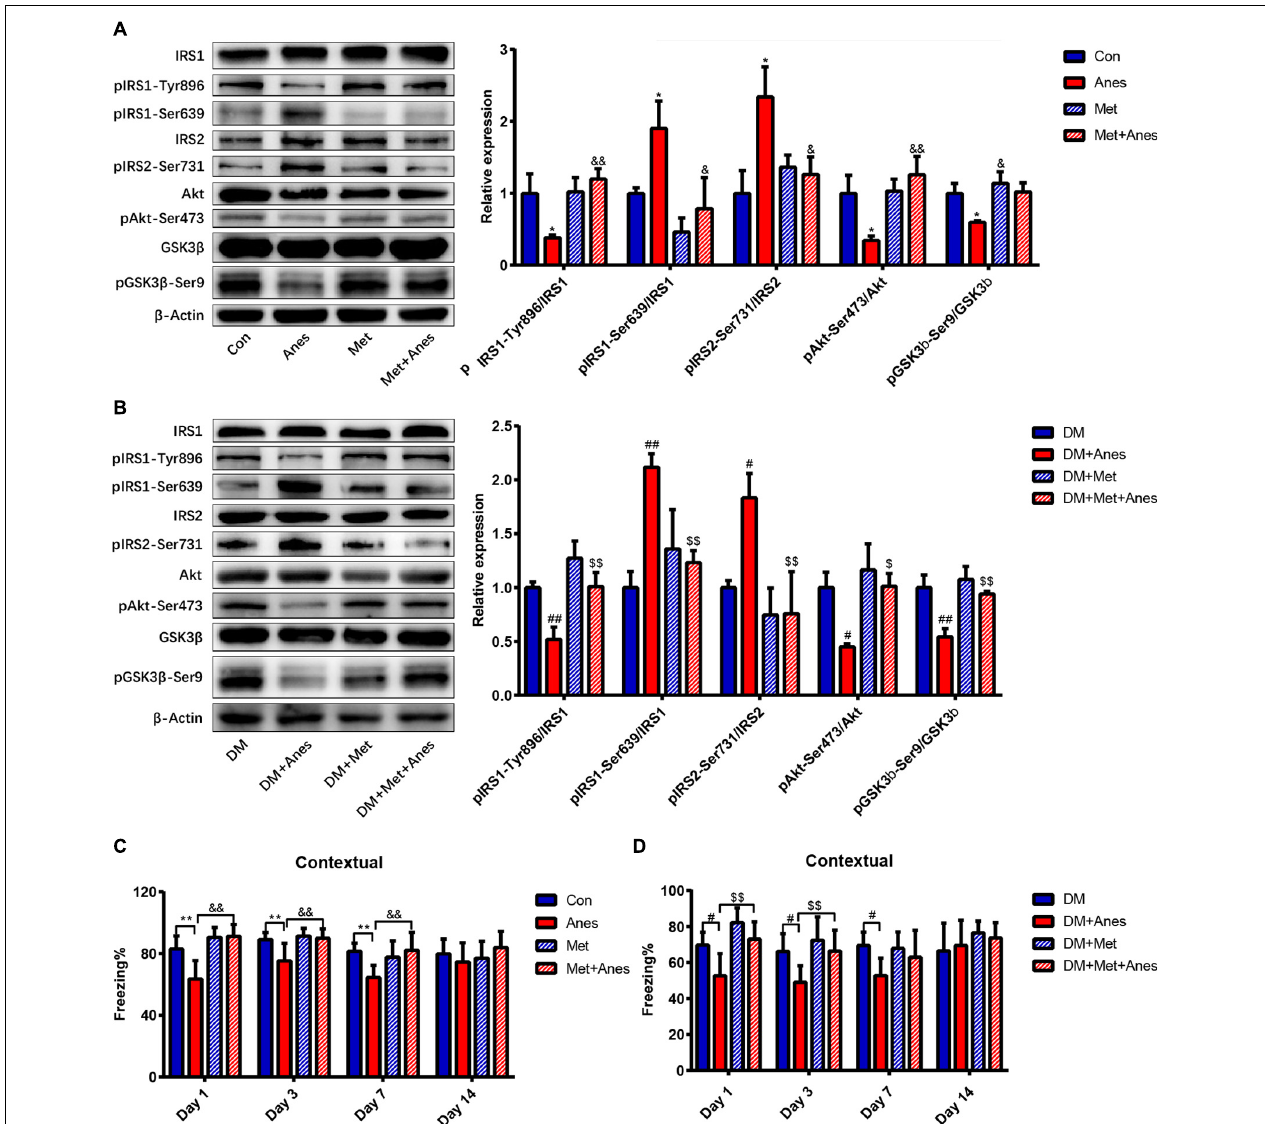
FIGURE 3 | Metformin alleviates hippocampal insulin resistance and impairs contextual fear memory induced by long-term isoflurane anesthesia, but not diabetic pathology. (A,B) Representative western blots (left panels) and densitometric analysis (right panels) showing the effects of isoflurane anesthesia, metformin, and anesthesia plus metformin pretreatment on the protein expression levels of hippocampal insulin-signaling pathway components in adult WT mice (B) and T2DM mice (C) ( n = 3 mice per group). (C) Freezing time to context by adult WT mice receiving vehicle (Con), anesthesia (Anes), metformin (Met, 50 mg/kg), or metformin before anesthesia (Met + Anes) ( n = 7–8). (D) Freezing time to context by T2DM mice receiving vehicle (DM), anesthesia (DM + Anes), metformin (DM + Met, 50 mg/kg), or metformin before anesthesia (DM + Met + Anes) ( n = 7–8 mice per group). Data are expressed as mean ± SD and analyzed with one-way ANOVA test followed